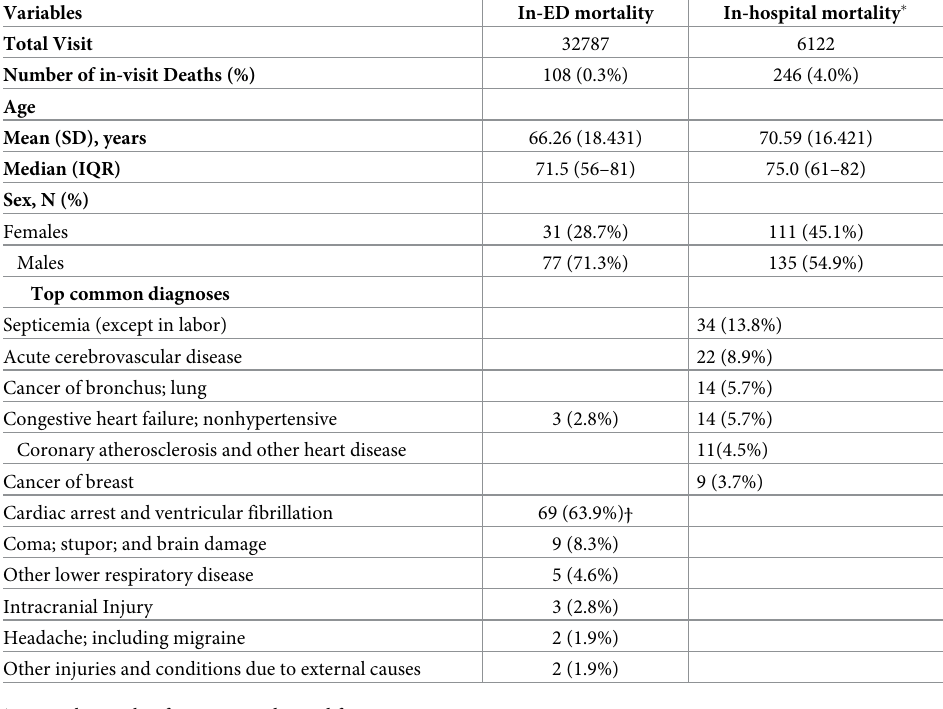
Table 2. In-ED and In-hospital